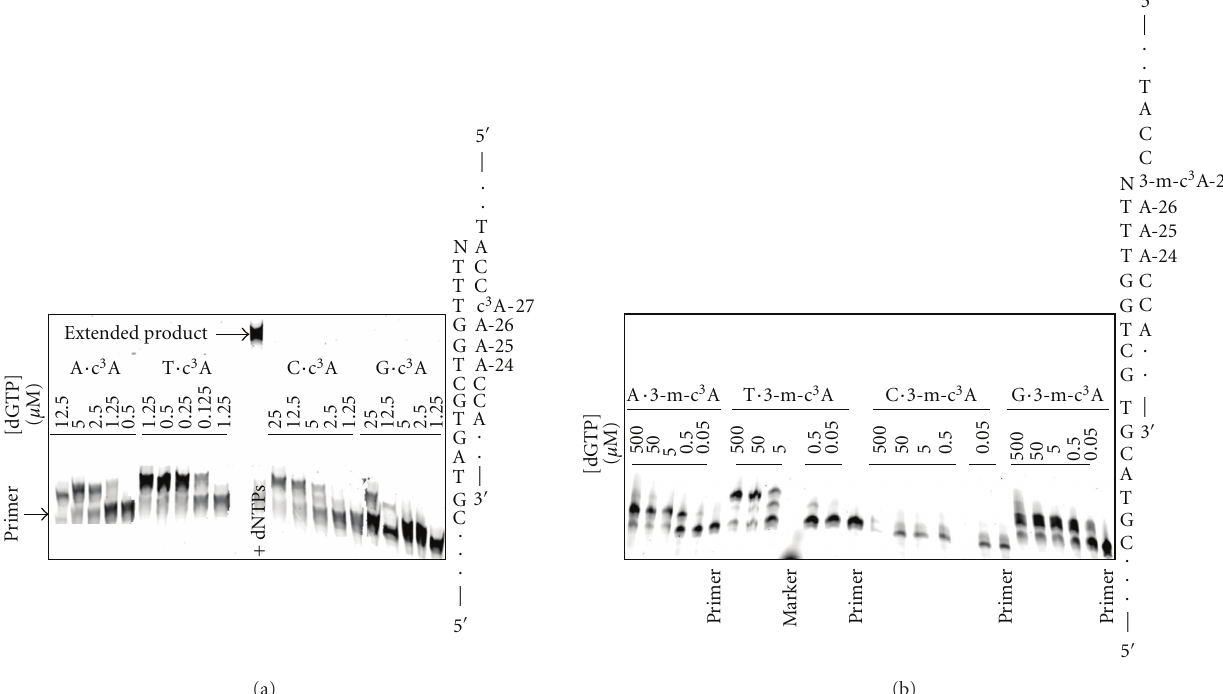
Figure 8: Extension from (A) c 3 A · N and (B) 3-m-c 3 A · N by T7 Sequenase. The template strand containing a c 3 A or 3-m-c 3 A at A-27 was annealed to a 5 (cid:2) -Cy5-primer (Table 1, P27). T7 Sequenase was added and the reactions initiated by the addition of the individual dNTP’s. Extension is most e ffi cient from c 3 A · T termini, while extension is similar from the 3-m-c 3 A · T and 3-m-c 3 A · G. Note that for 3-m-c 3 A · G only one dGTP is added rather than the two observed for 3-m-c 3 A ·